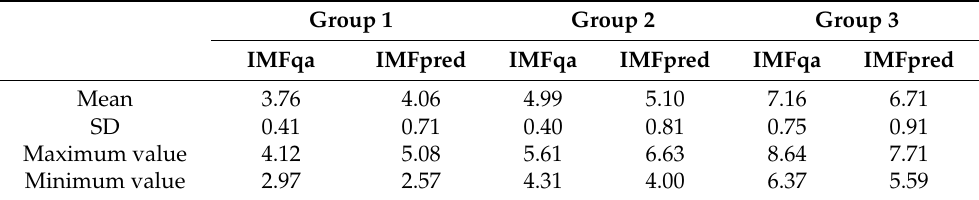
Table 3. Summary of mean, SD, minimum value and maximum value of quantified IMF (IMFqa, extracted from the meat) and of predicted IMF (IMFpred) in the three groups (Group 1: IMF ≤ 4.24%; Group 2: 4.25% ≤ IMF ≤ 5.75%; and Group 3: IMF > 5.76%).